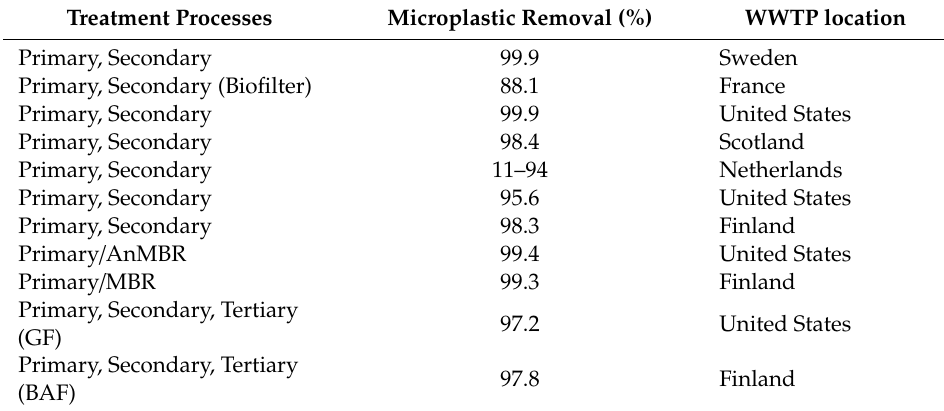
Table 2. Microplastic removal by di ff erent wastewater treatment plants (WWTPs) (Data elaborated from Sun et al.